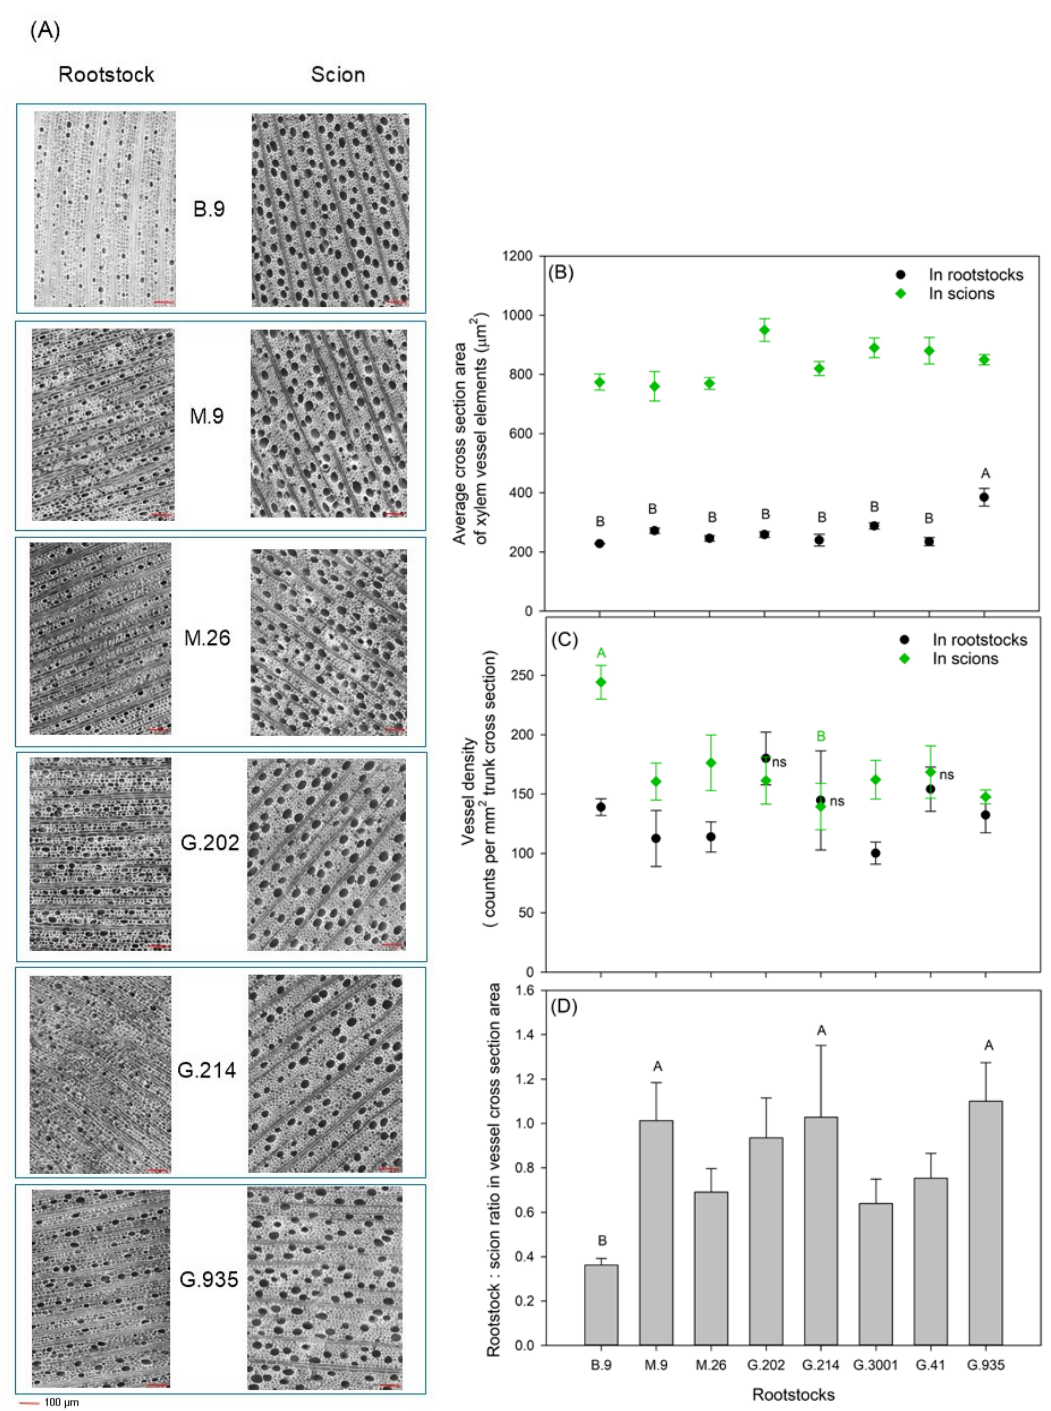
Figure 6. Characteristics of xylem vessel elements in 10-year-old Honeycrisp trees in the combination with eight rootstocks. ( A ) Cross-section of xylem vessel elements in rootstocks and scions, with autofluorescence visualized under 100 × magnification of a confocal microscope; ( B ) Average size of cross-section of individual xylem vessel elements in scions and rootstocks; ( C ) Xylem vessel density in scions and rootstocks; and, ( D ) Rootstock: scion ratio in total xylem vessel cross-section area ( VCSA rootstock : VCSA scion ). Different letters stand for significant difference between rootstocks, whereas ns indicates no significant difference between the rootstock and its scion ( p ≤ 0.05, ANOVA; Tukey–Kramer Pairwise Comparisons for ( A ) and ( B ), and Fisher LSD Pairwise Comparisons for (C); n = 3 trees, approximately 500 vessels of each type were analyzed for each rootstock–scion